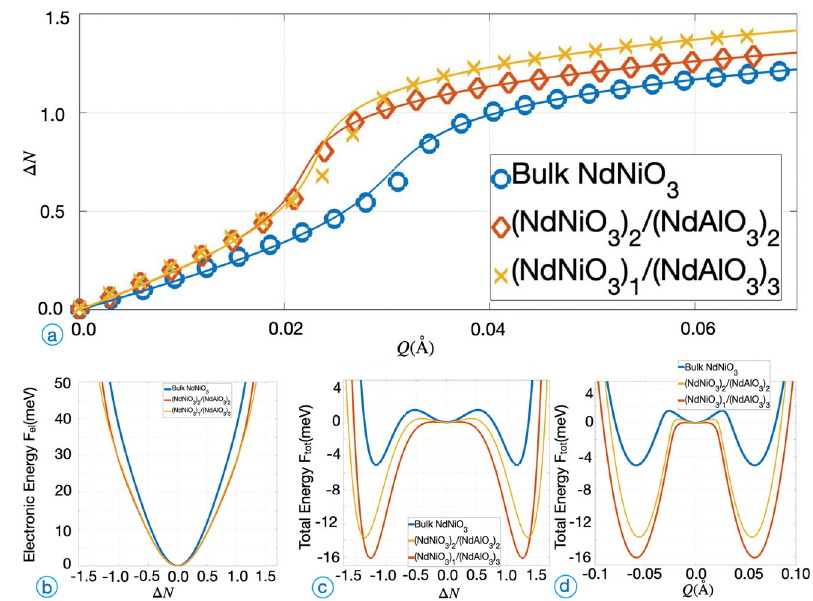
Fig. 6 Equation of state fi t, and electronic and total energy for bulk NdNiO 3 and layered NdNiO 3 /NdAlO 3 structures. a Data showing electronic disproportionation as a function of structural distortion Δ N ( Q ), from 4 (points) and the polynomials (light lines) obtained by fi tting the data to the equation of state, Eq. 7. b Electronic and c total energy as functions of electronic order parameter Δ N for bulk NdNiO 3 and for superlattices consisting of a bilayer of NdNiO 3 alternating with NdAlO 3 and a monolayer of NdNiO 3 alternating with three layers of NdAlO 3 using data from ref. 4 . d Total energy as function of octahedral distortion Q after minimizing over electronic disproportionation Δ N . Note change of y -axis scale between panel a and other two panels. Energy normalized to correspond to 10 atom unit cell for the bulk, and per two Ni atoms (one layer) of NdNiO 3 in the superlattices.